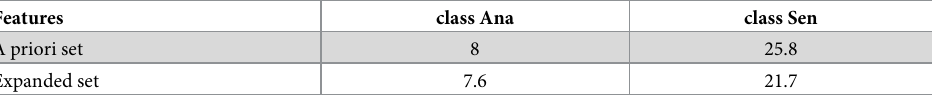
Table 1. Mean absolute error (MAE) of the peanut allergy score prediction in ML models with an abridged (a pri- ori known) set of features and an expanded set of features, each optimized to include only relevant features. Ground truth values are multiples of 20. LOO cross-validation is used.